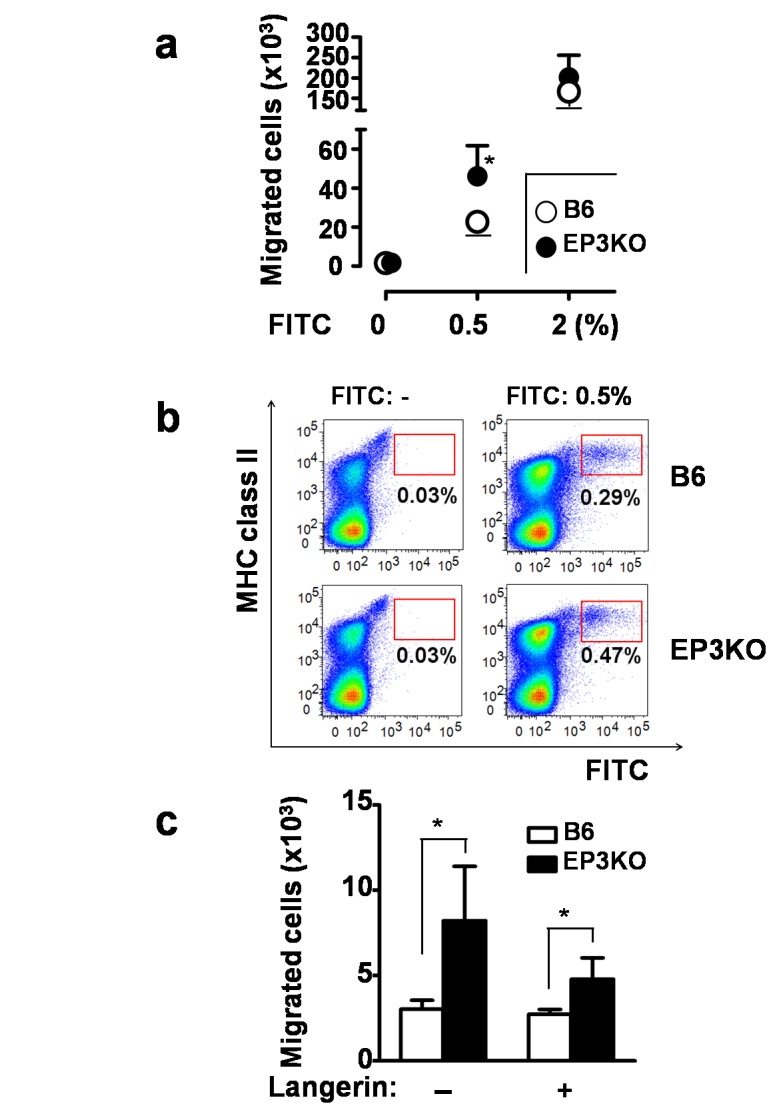
Enhanced cutaneous DC migration in EP3KO mice.(a) The number of FITC+ MHC class II+ DCs in the draining lymph nodes from EP3KO and WT mice 96 hours after application of 0.5 or 2% FITC (n=4). (b) Representative flow cytometry of lymph node cells. (c) The numbers of FITC+ LCs (FITC+ Langerin+ cells) or dermal DCs (FITC+ Langerin- cells) in the draining lymph nodes of the mice after application of 0.5% FITC. White and black columns indicate B6 and EP3KO mice, respectively (n=4). Each data represents the mean + SD. *p<0.05.